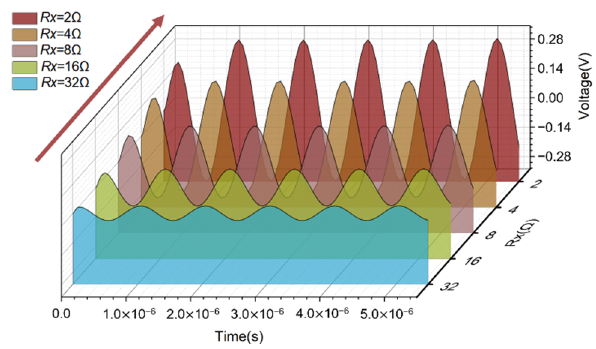
Figure 3. Effect of coil quality factor on bridge sensitivity.